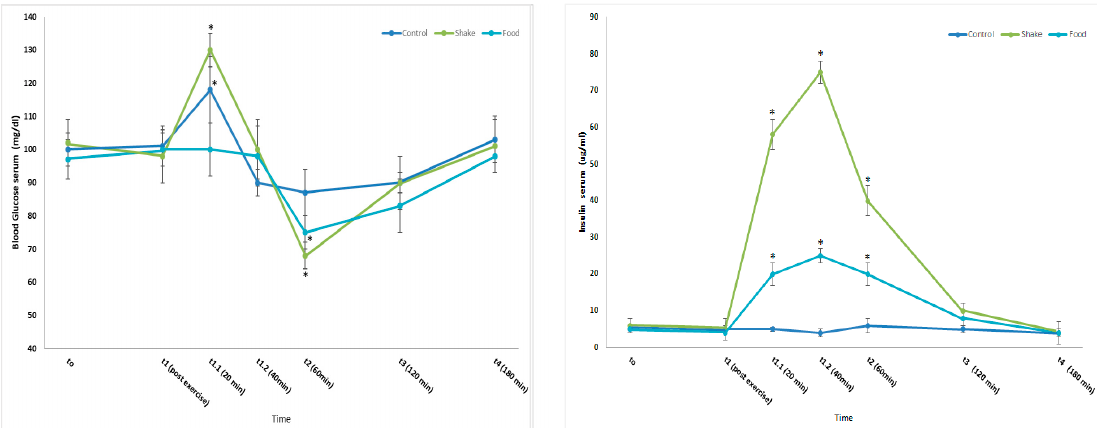
Figure 2. Effects of protein/carbohydrate uptake via food and shake, immediately after exercise, on serum glucose and serum insulin serum concentrations. Left: Mean serum blood glucose concentrations of all participants. All data are expressed as mean ± SD. * = p ≤ 0.05. Statistically significant differences between marked time points and respective t0 value are observed. Right: Serum insulin concentrations of all participants (Mean ± SD). * = p ≤ 0.01 show statistically significant differences between marked time point and respective t0 value in each condition.